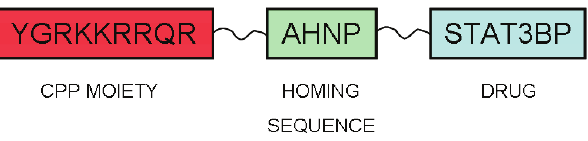
Figure 3. “Modular approach” design for targeted drug delivery systems